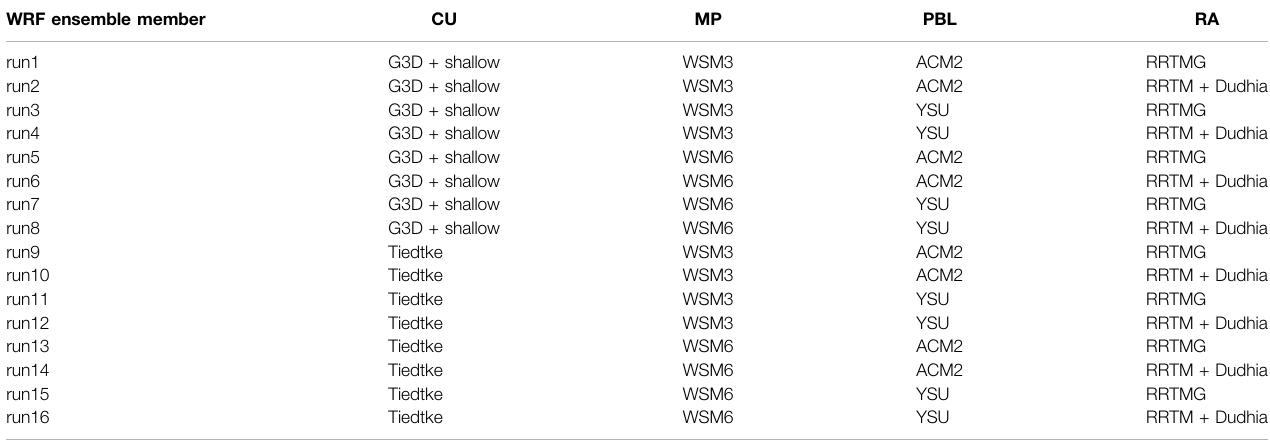
TABLE 3 | Full factorial WRF parameterization combinations, consisting of two cumulus parameterization (CU), two microphysic parameterization (MP), two planatery boundary layer parameterization (PBL), and two radiation parameterization (RA) schemes. WRF ensemble